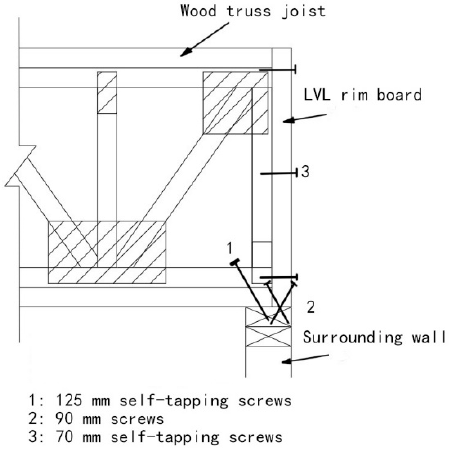
Figure 2. Dimensions of timber truss (unit: mm).